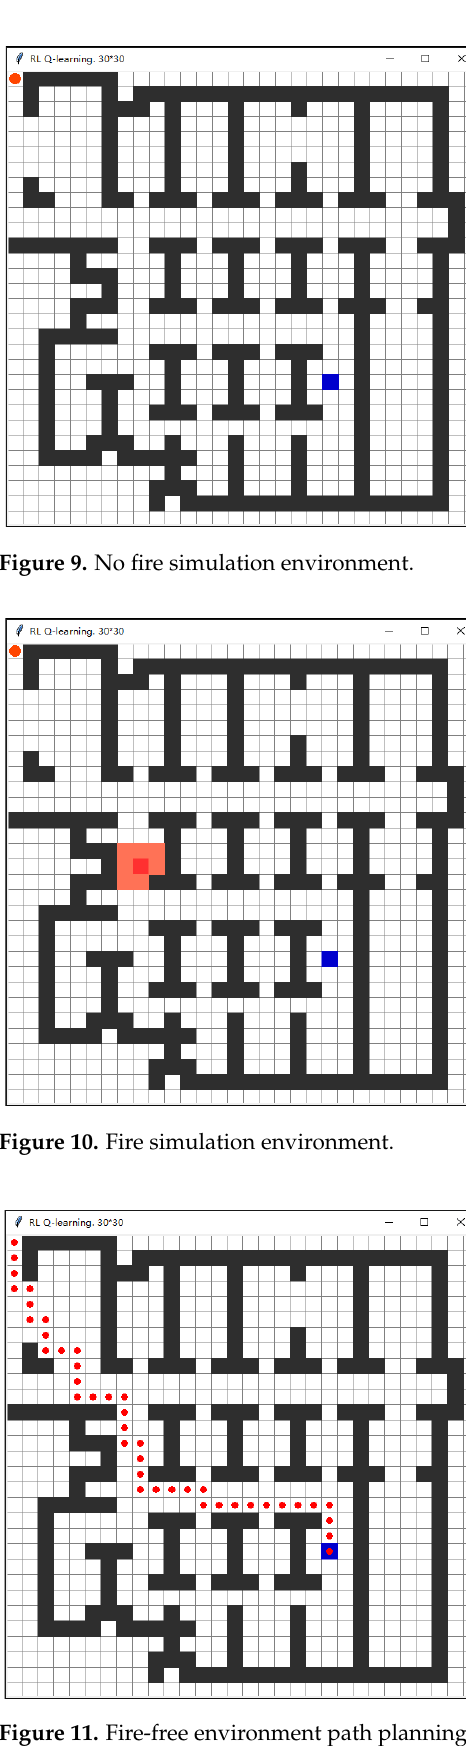
Figure 11. Fire-free environment path planning.